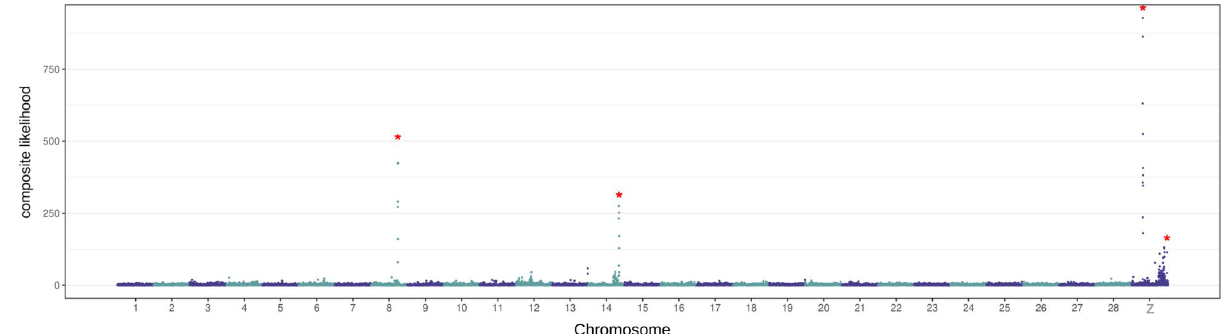
Figure 4. Loci under adaptive evolution The composite likelihood of being targeted by selective sweeps in invasive populations. The x-axis represents the coordinates of grids in the reference genomes, and the y-axis